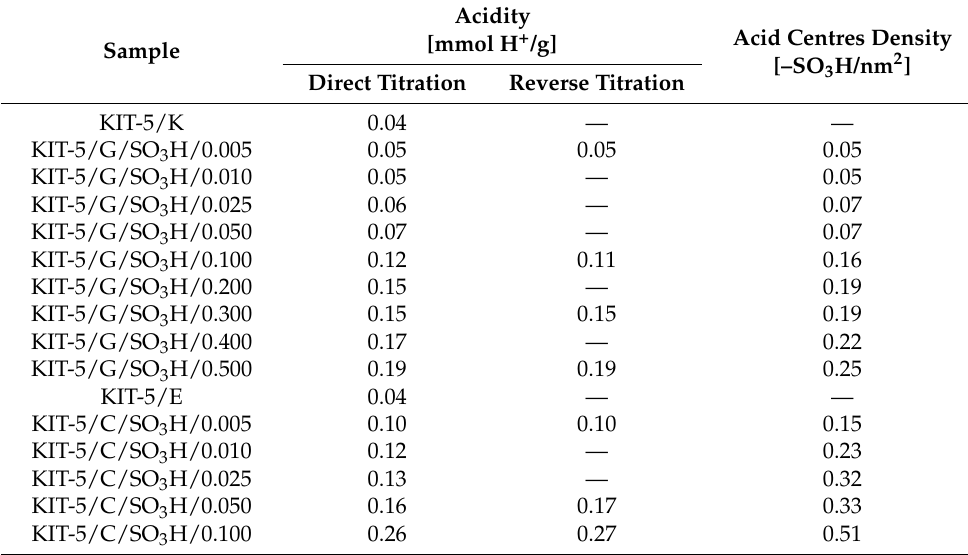
Table 4. Acidity analysis of KIT-5 type materials modified with sulfonic groups by grafting or